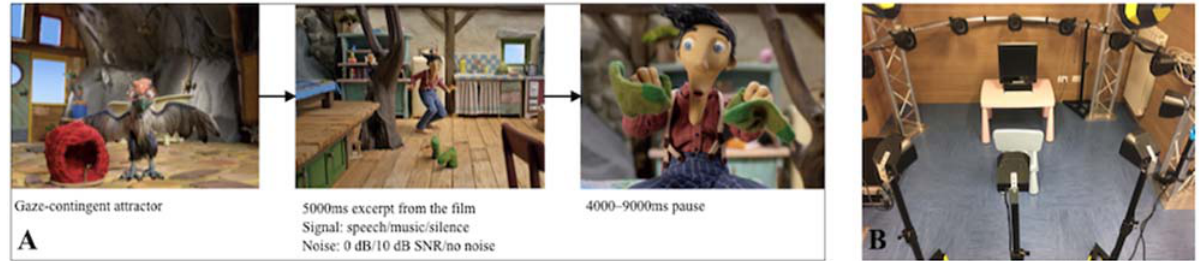
Figure 1. ( A ) The schematic representation of the trial structure. ( B ) A photo of the experimental setup. Older children were seated on the chair in front of the screen; younger children were seated in their parents’ lap.